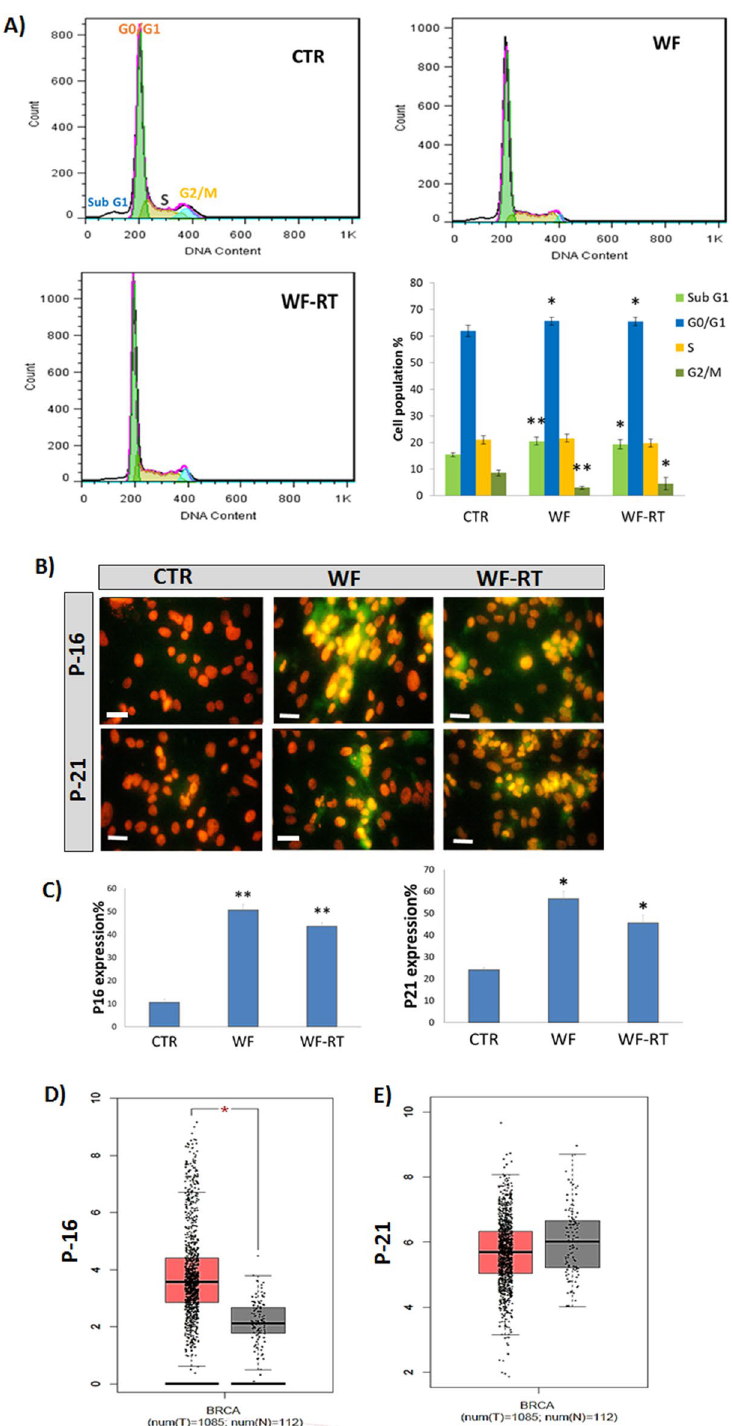
Figure 5. Effect of WFs on the cell cycle distribution of MDA-MD-231 cells. ( A ) Flow cytometry analysis for treated and untreated MDA-MB-231 cells. ( B ) Quantitative analysis of cell cycle arrest at the G0/G1 phase. Data represent mean ± SD of triplicate, *P < 0.05, and **P < 0.01. Scale bars: ×100. Original magnification: 10 µm. ( C ) The graphs represent the expression levels of P16 and P21 in MDA-MB-231 cells. The data represents the means ± standard deviations (SDs) of 3 independent tests. Green = P16 and P21, Red = PI. CTR: control (DMEM + 10%FBS), WF: wound fluid, WF-RT: IORT-treated wound fluid. ( D , E ) The expression levels of P16 and P21 in breast cancer and normal tissues were analyzed using GEPIA. In the box plots, the thick lines in the middle represent the median, and the upper and lower limits of the box represent the third and first quartiles, respectively. The top and bottom of the error bars represent the maximum and minimum data values, respectively; outliers were considered > 1.5 quartile spacing and excluded. *P < 0.05. T tumor, N normal, num